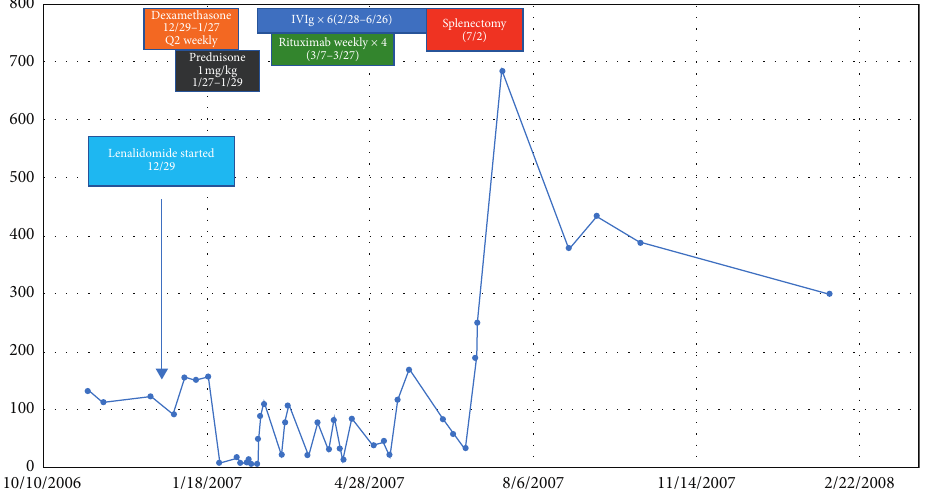
Figure 2: The platelet count and treatment history of the case.